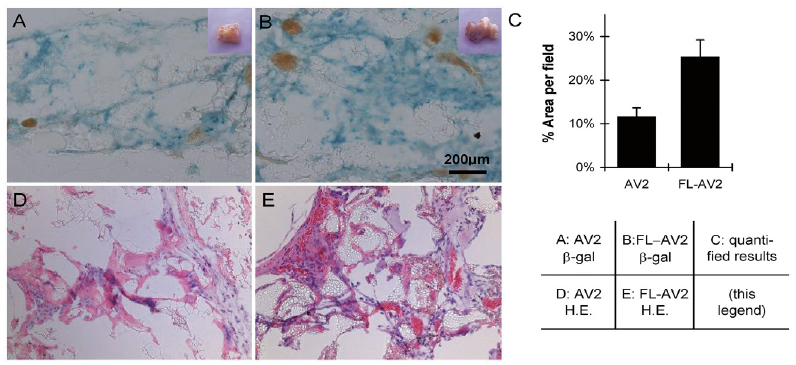
Fig 5. Long term transduction of antibody immobilized FL-AV2 in 3D cell cultures in vivo . PLGA scaffolds immobilized with FLAG antibodies were loaded with FL-AV2.LacZ and used as the 3D culture matrix for HeLa cells. After 48 h of culture, the seeded cells in scaffolds were implanted into the subcutaneous tissue under the neck skin of nude mice. After 4 weeks, the tissues surround the implanted regions were removed and subjected for histological examinations. Images of frozen sections stained with a β -galactosidase staining kit (A and B) or with H.E. staining (D and E) were obtained using a Leica DM 5000 B microscope. Randomly selected 9 non-overlapped microscopic fields were analyzed for the area percentages of β -gal stained regions(C), and the values were used as a semi-quantitative indication of viral transduction efficiencies.